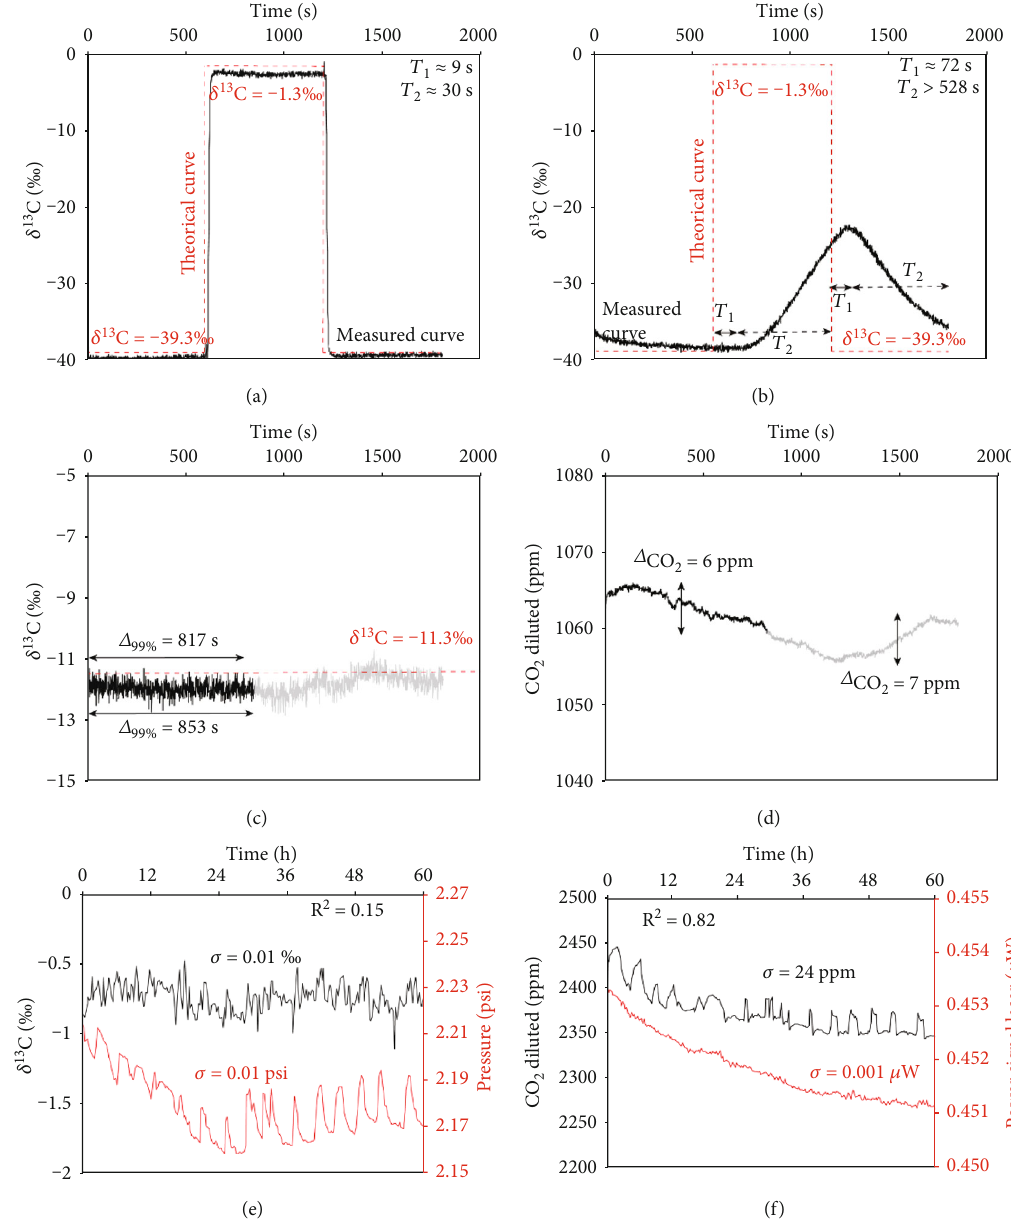
Figure 5: Raw signal (1 Hz) of simulated mixing between two gas samples ( δ 13 C = − 39 : 3 ‰ and -1.3 ‰ , respectively) by switching the valve is the time required for the gas to start entering in the each 10 min without the dilution system (a) and with the dilution (yellow) system (b). Τ 1 absorption cell. Τ is the time required to eliminate the e ff ect of gas mixing in the tube and the absorption cell. Red values and lines represent 2 the theoretical signal expected from the analyzed sampling bag. (c) Example of potential long-term δ 13 C instability of the raw signal (1 Hz) for 30min of measurements of a reference sampling bag. Δ and Δ are, on average, the maximum time for which the precision is better than 99 % 95 % contents. (e) Long time 99% and 95% of the maximum precision, respectively (Appendix 1). (d) Synchronous variability of measured CO 2 acquisition (65 h) of δ 13 C values (averages on 15min cycles in black) of a standard gas with a fi xed isotopic composition. Synchronous variations of the internal Delta Ray IRIS cell pressure are reported (in red). (f) Synchronous long time acquisition (65 h) of diluted CO 2 contents (averages on 15min cycles in black; yellow wire) of a standard gas with a fi xed CO amount. Synchronous variations of the 2 power of the laser signal are reported (in